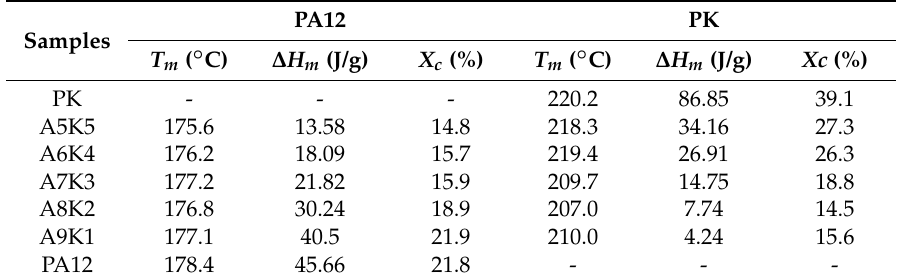
Table 3. Melting parameters of PA12, PK and the blends determined from Figure 6b. Xc are normalized. Samples